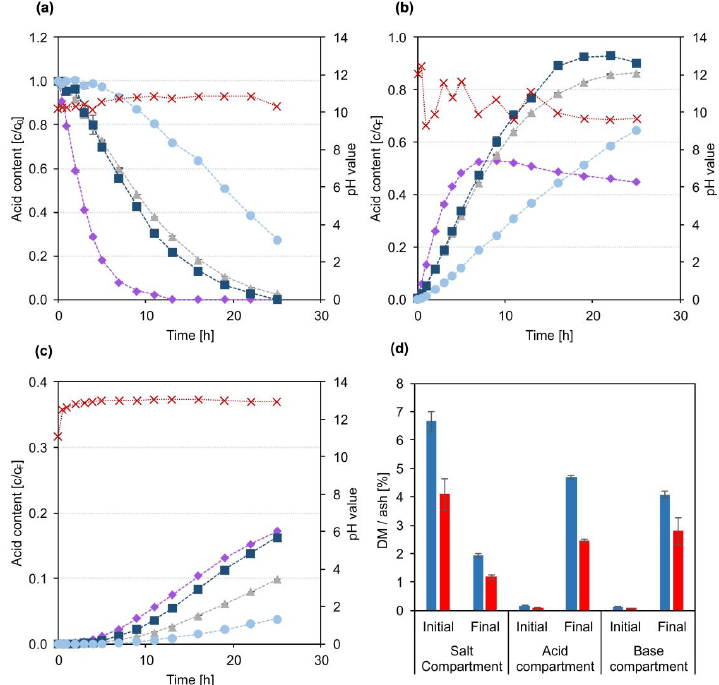
Figure 5. Development of carboxylic acid concentrations and pH value over the course of the long- term EDBM experiment with BL model solution. ( a ) Salt compartment; ( b ) acid compartment; ( c ) base compartment. For ( a – c ): ■ glycolic acid, ● lactic acid, ♦ formic acid, ▲ acetic acid, x pH value.